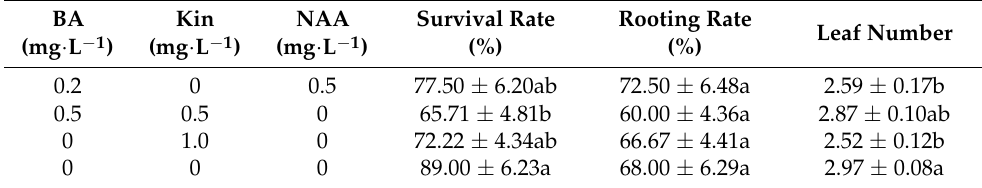
Table 7. Effect of plant growth regulators on root and leaf growth of Paphiopedilum tigrinum .